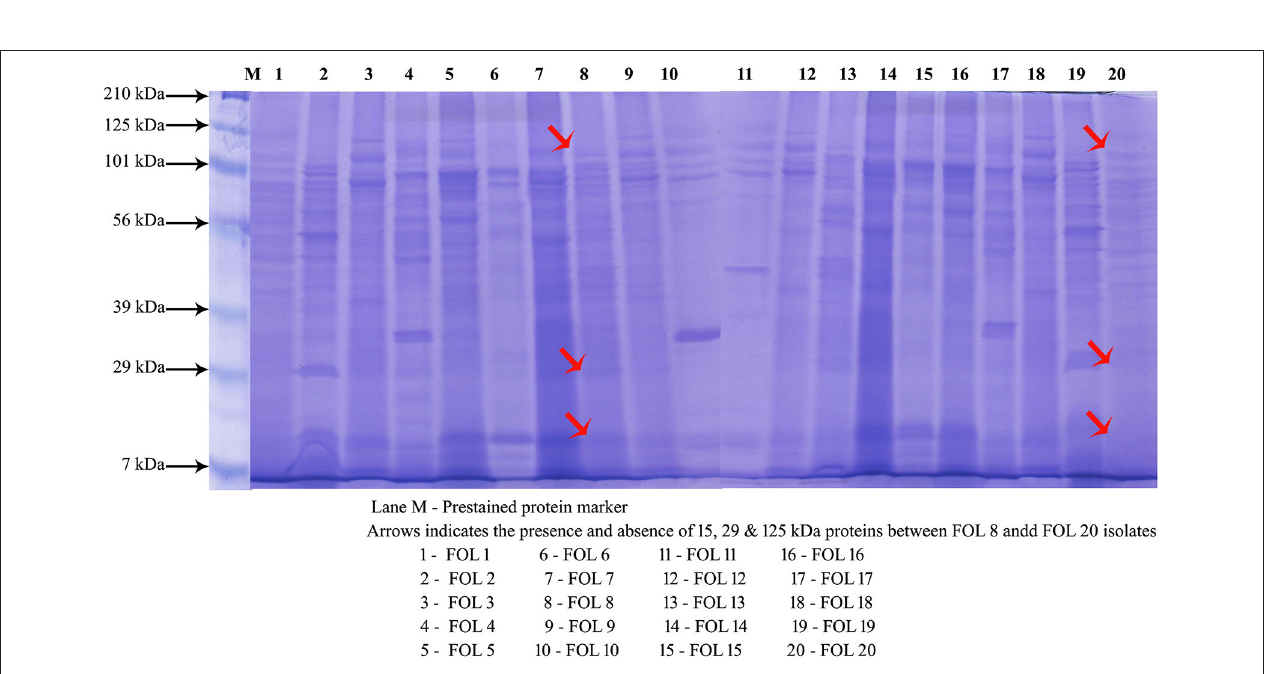
proteins were identified with NCBI accession number of homology protein, score, experimental and theoretical pI- value and molecular weight ( Table 4 ). All the identified proteins have broad spectrum activity, that is consistent with successful disease development, host-pathogen compatibility, electron carrier activity, catalytic activity, transfer of sulfate ions, hydroxylation and oxidation, breakdown of toxins, plant penetration and maintenance of genome integrity ( Figures 5 , 6 , Table 5